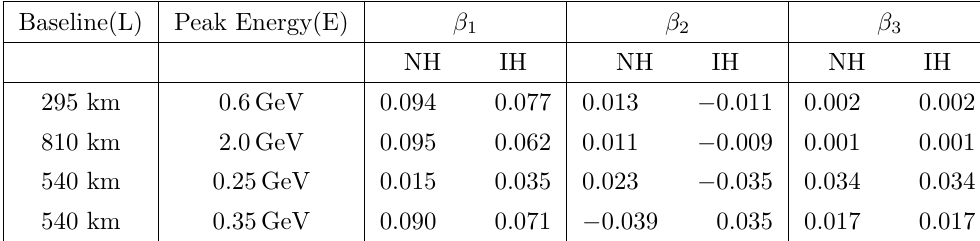
Table 1 . (cid:12) 1 , (cid:12) 2 & (cid:12) 3 values in eq. (2.3) for 295 km, 810 km, and 540 km baselines corresponding to T2K, NO (cid:23) A and ESS (cid:23) SB experiments.The energies correspond to the values where the (cid:13)ux